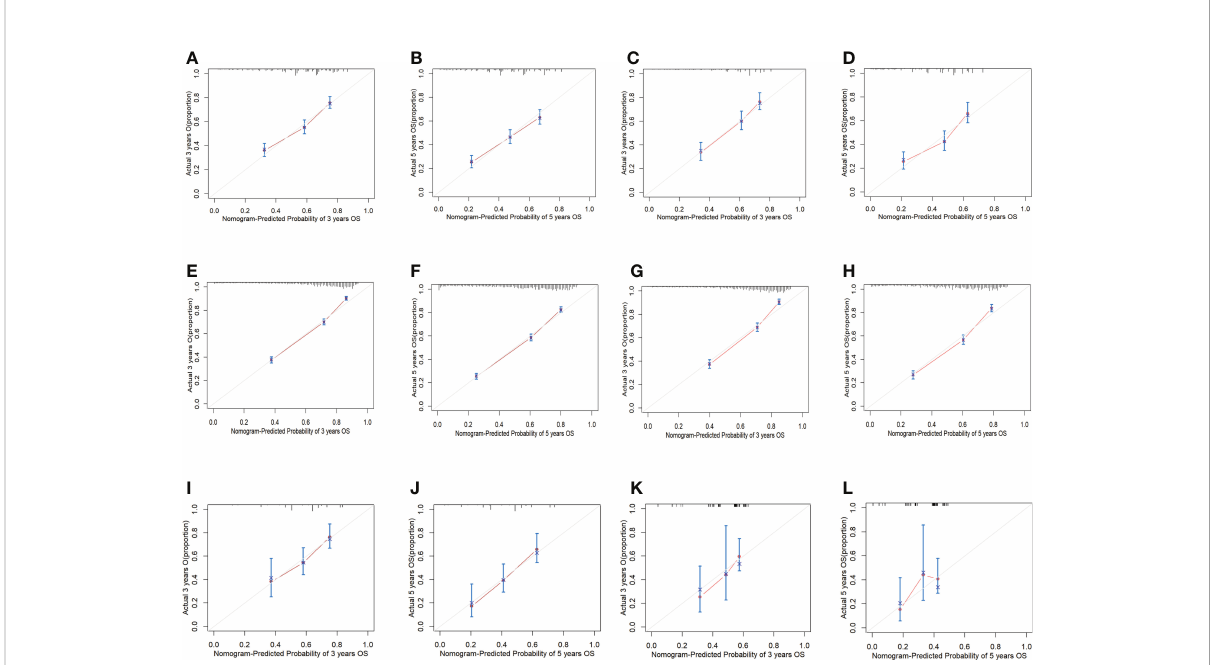
FIGURE 6 Calibration graphs of all cohorts. (A) Calibration graph of predicting 3-year OS for the fi rst cohort training set. (B) Calibration graph of predicting 5-year OS for the fi rst cohort training set. (C) Calibration graph of predicting 3-year OS for the fi rst cohort validation set. (D) Calibration graph of predicting 5-year OS for the fi rst cohort validation set. (E) Calibration graph of predicting 3-year OS for the second cohort training set. (F) Calibration graph of predicting 5-year OS for the second cohort training set. (G) Calibration graph of predicting 3-year OS for the second cohort validation set. (H) Calibration graph of predicting 5-year OS for the second cohort validation set. (I) Calibration graph of predicting 3- year OS for the third cohort training set. (J) Calibration graph of predicting 5-year OS for the third cohort training set. (K) Calibration graph of predicting 3-year OS for the third cohort validation set. (L) Calibration graph of predicting 5-year OS for the third cohort validation